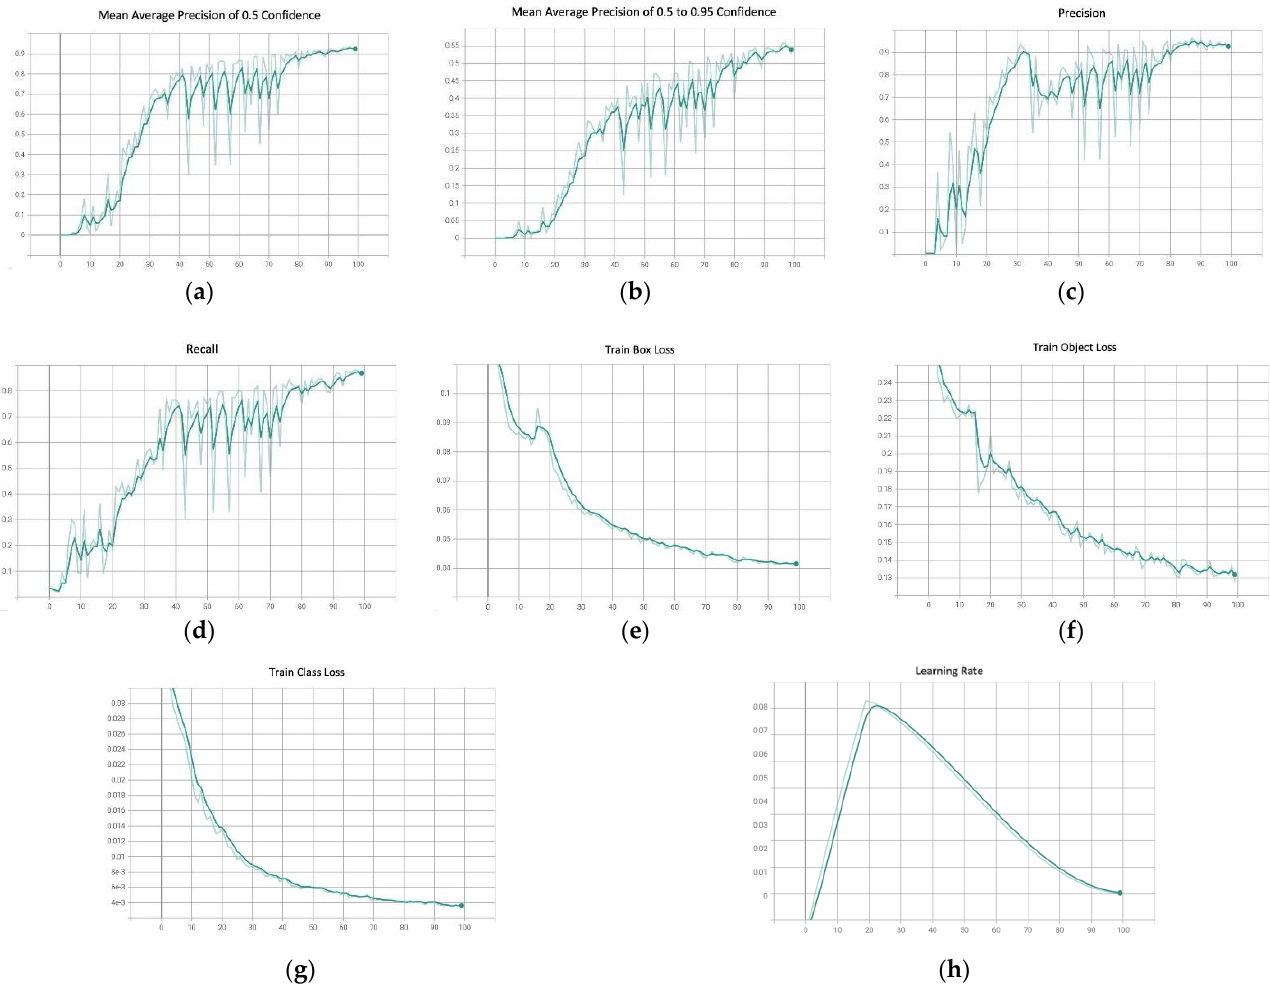
Figure 8. Sample detected output of the YOLOv5 model.